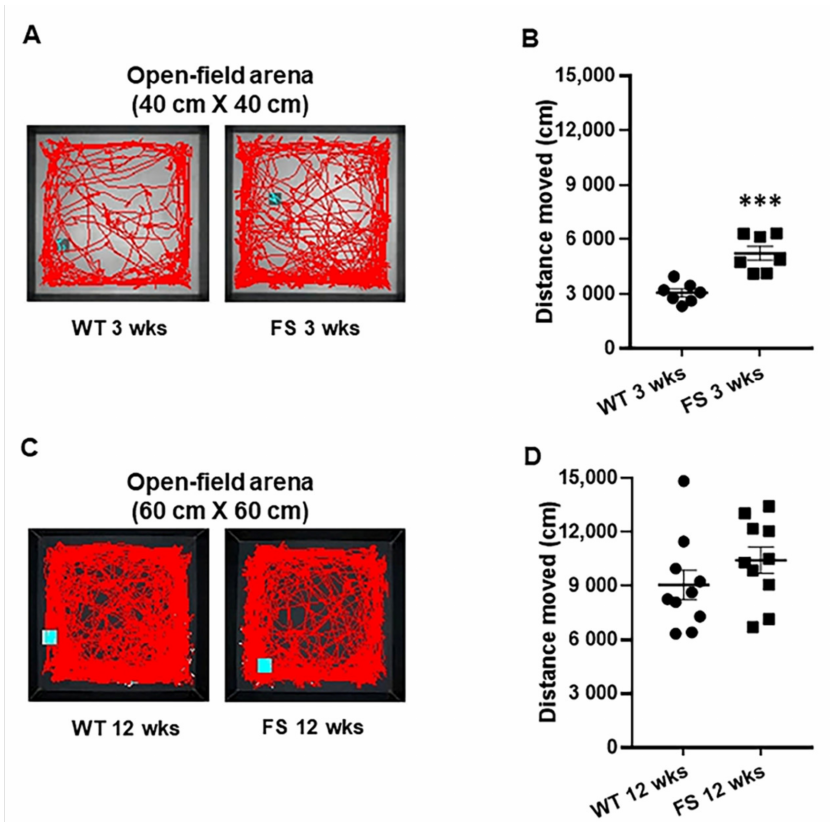
Figure 3. Increased levels of locomotion in FS juvenile rats, but not in FS 12 weeks rats. Representative movement traces of FS 3 weeks rats, FS 12 weeks rats, and wild-type littermates in open-field test ( A , C ). FS 3 weeks rats showed hyperlocomotor activities in comparison with wild-type rats after 3 weeks ( A , B ). FS 12 weeks rats and wild-type littermates showed similar levels of locomotor activities ( D ). Data are presented as means ± standard errors of the mean. *** p < 0.001, two-tailed t -test (WT 3 weeks, n = 7; FS 3 weeks, n = 7; WT 12 weeks, n = 10; FS 12 weeks, n =